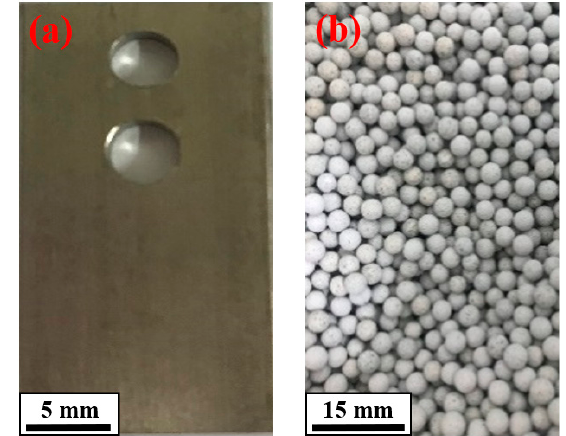
Figure 1. ( a ) 304 stainless specimen, ( b ) brown corundum particles. Table 1. Chemical elements of 304 stainless steel used in this study.